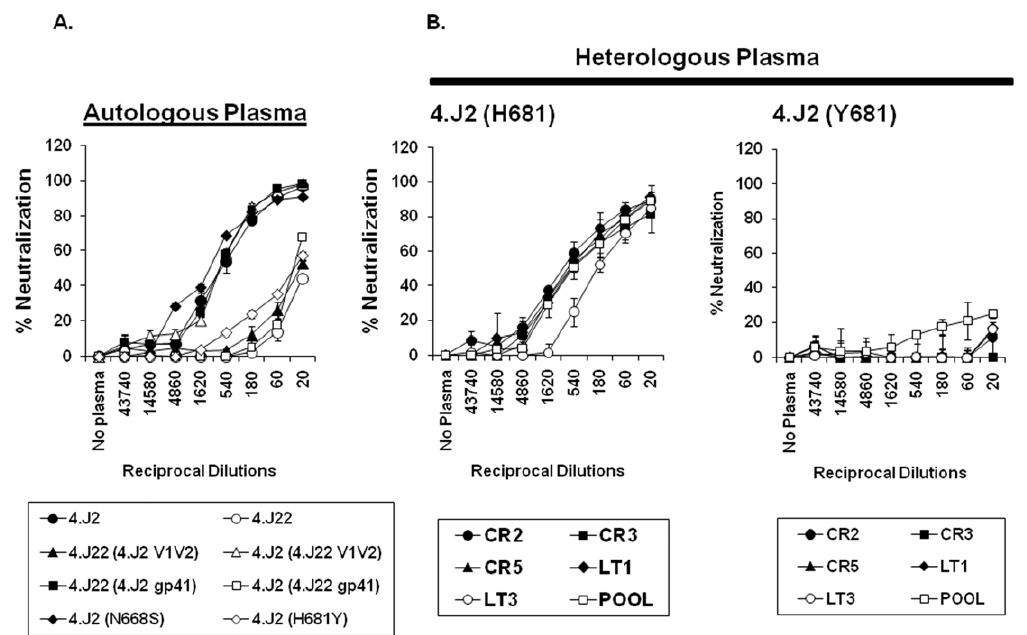
Figure 2. Neutralization of patient Envs by autologous and heterologous plasma antibodies. A. Neutralization curves of Env- pseudotyped viruses carrying chimeric Envs as well as with point substitutions at positions 668 and 681 were tested against autologous plasma antibodies. Percent neutralization at various dilutions of plasma is plotted and compared with virus control (VC) where growth medium was used instead of plasma. Note that the gp41 has modulated the neutralization sensitivity to autologous plasma and specifically H681Y substitution in 4.J2 Env was found to associate with reduced neutralization sensitivity to autologous plasma. B. 4.J2 Env carrying H681 was found to confer enhanced sensitivity to HIV-1 + heterologous plasma samples (CR2, CR3, CR5, LT1, LT3) while Y681 rendered significant reduction of 4.J2 Env sensitivity to same heterologous plasma samples. Plasma pool represents the mixture of above five plasma specimens. The neutralization assays were done in duplicate and in at least three independent experiments. In all cases, VC stands for virus control where plasma was not added and thus considered as 0% neutralization.